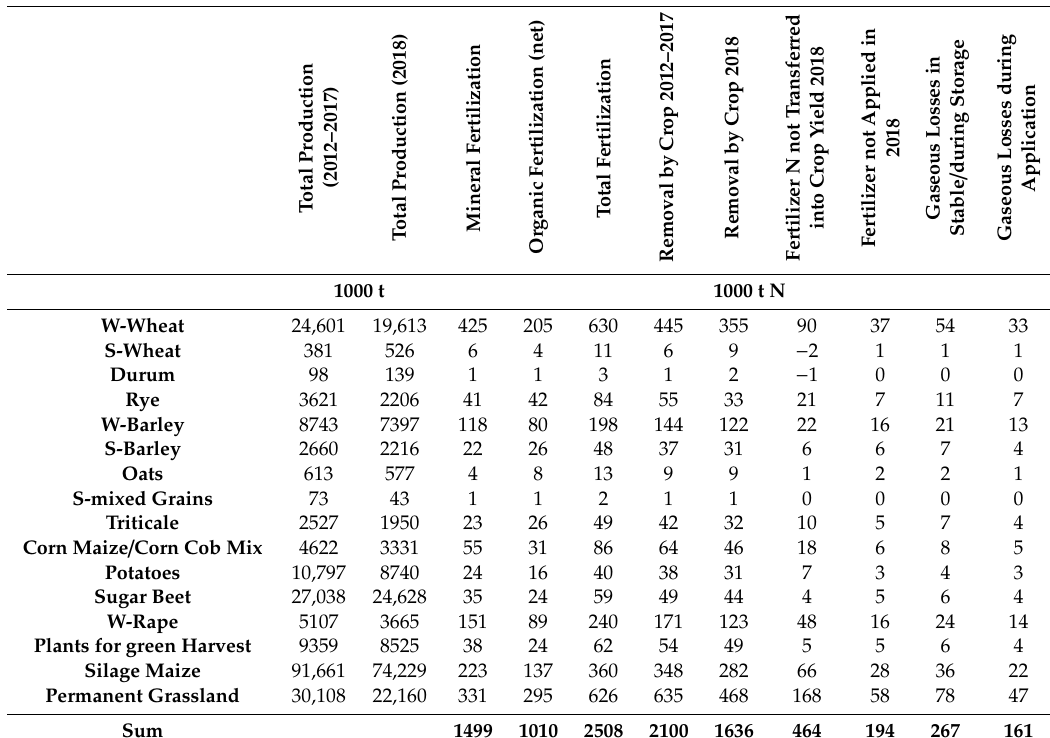
Table 2. Calculated nitrogen supply for di ff erent crops from available organic and mineral fertilization, according to average yields (2012–2017) and rough estimates on nitrogen mineralization based on regulations of German Fertilization Ordinance